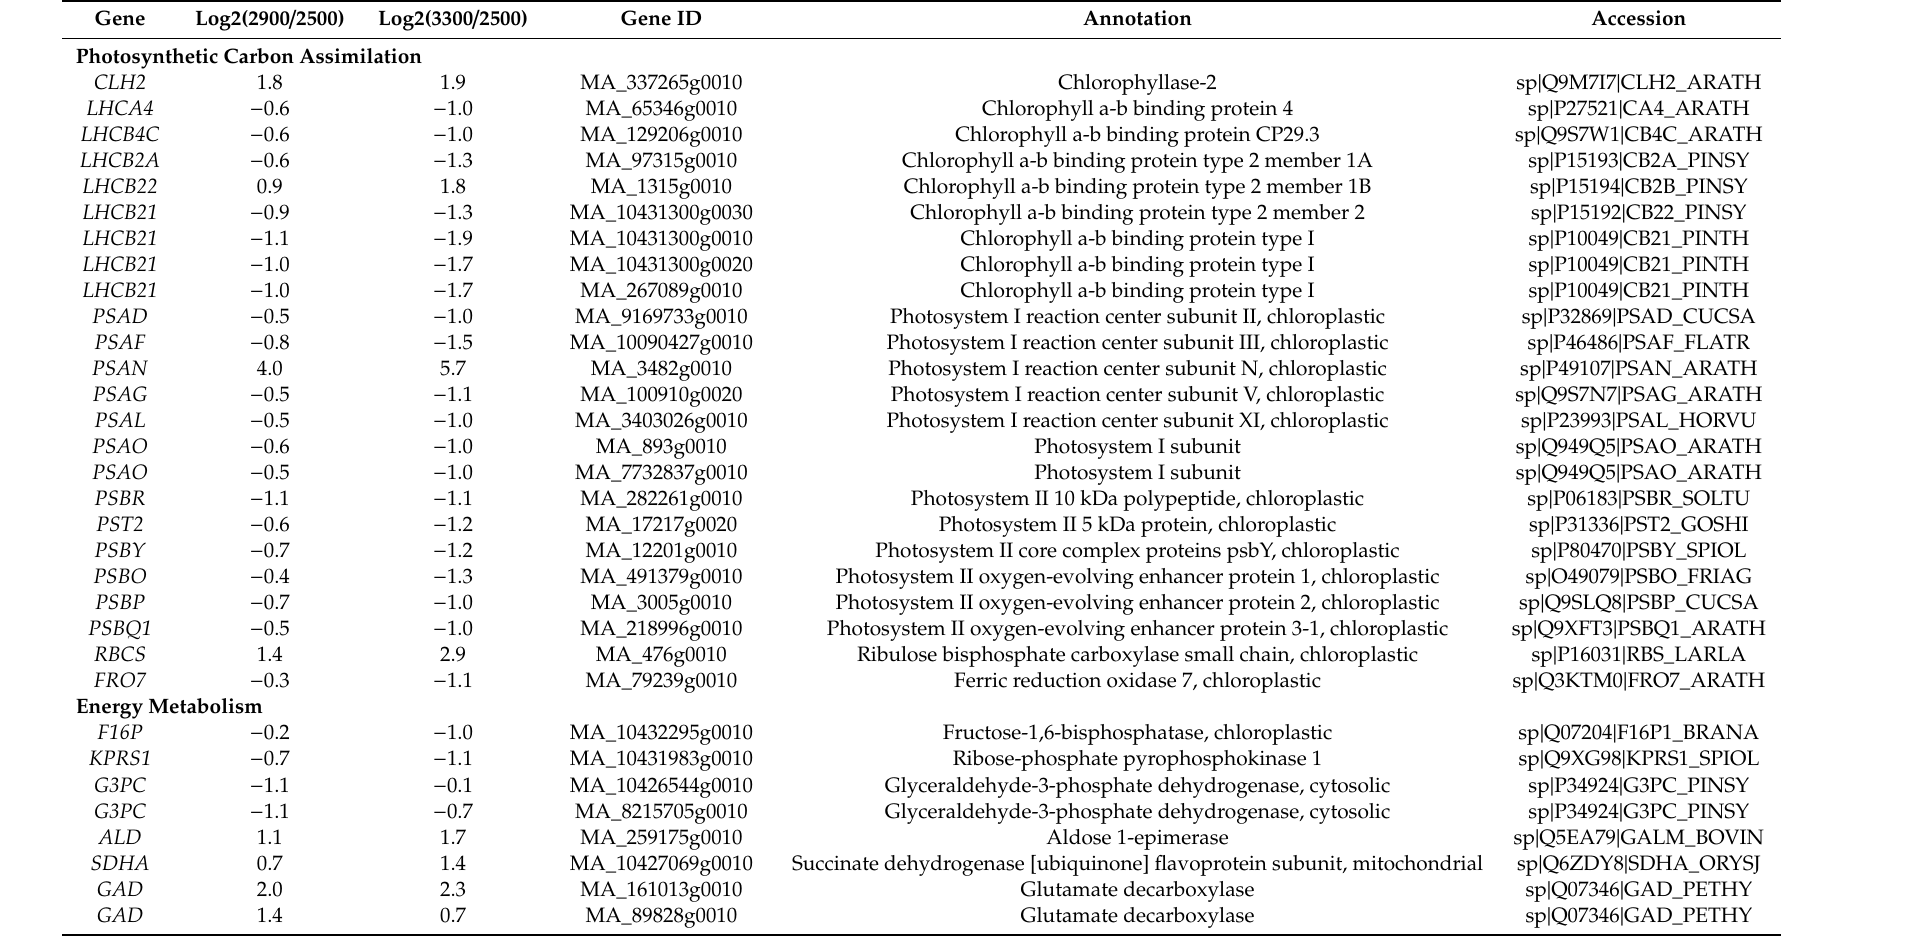
Table 1. DEGs involved in carbon assimilation and carbon